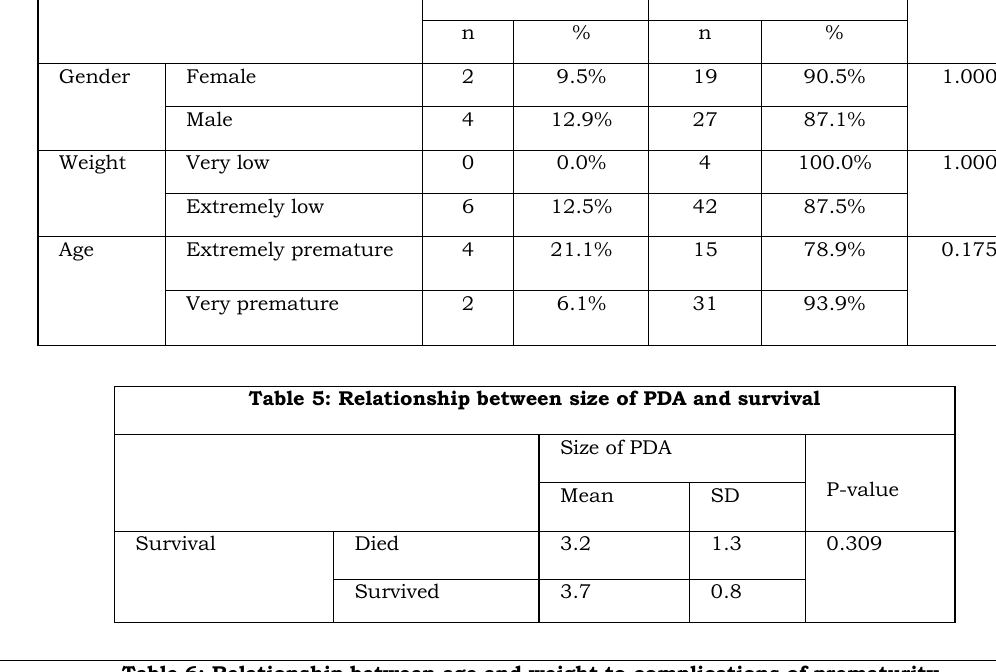
Table 6: Relationship between age and weight to complications of prematurity